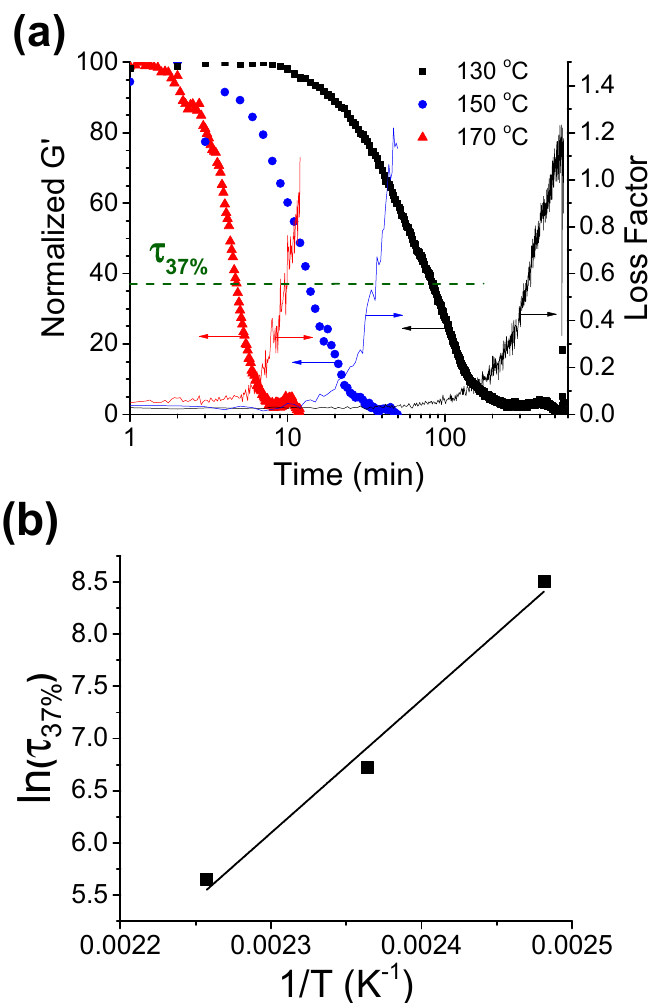
Figure 5. ( a ) Stress relaxation of crosslinked PBA networks. Samples were held at a frequency of 10 rad/s and an applied strain of 0.1% at a given temperature until degradation was complete. The loss factor is the tan δ = G”/G’. ( b ) Arrhenius plot of the logarithm of chain relaxation at 37% G 0 (ln τ 37% ) against inverse temperature for stress relaxation experiments.